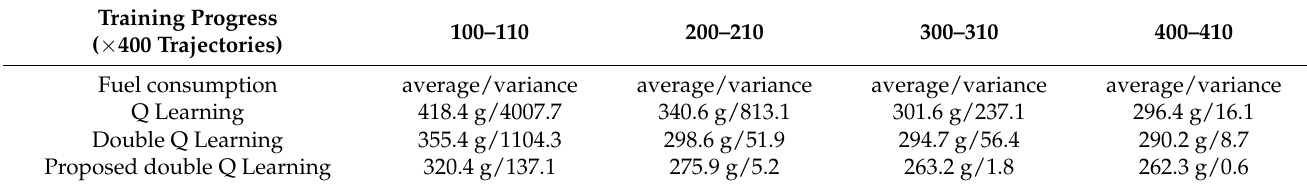
Table 4. Convergence comparison of different algorithms.